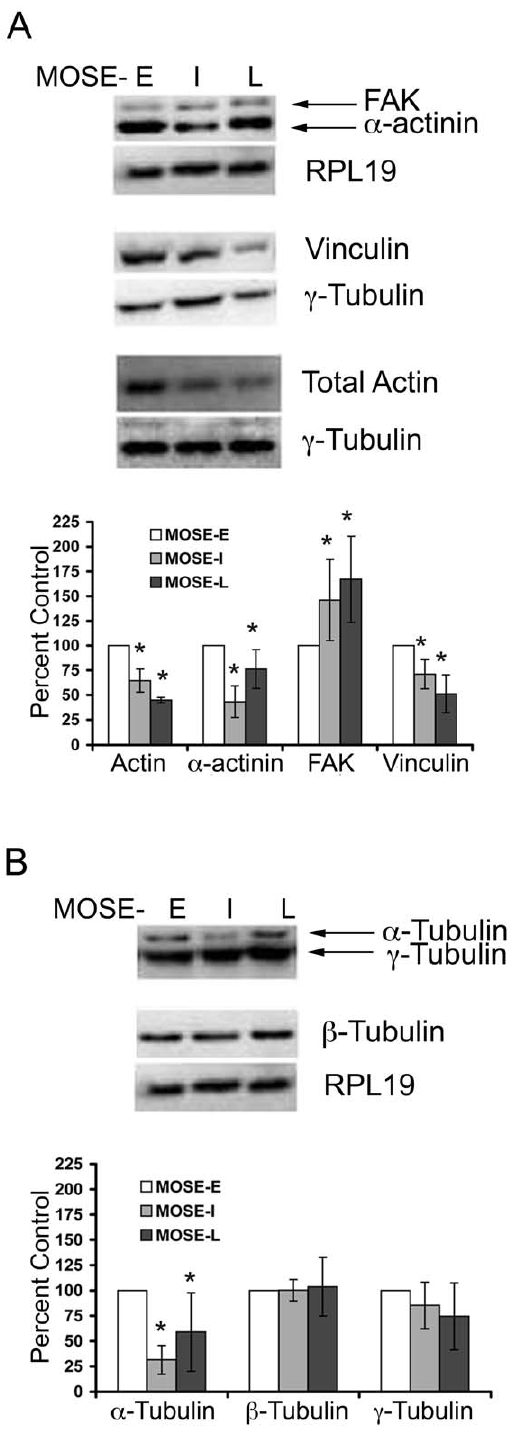
Figure 2. Levels of cytoskeleton and actin regulating proteins in neoplastic progression. Whole cell extracts from MOSE-E (E, white bars), MOSE-I (I, grey bars), and MOSE-L (L, black bars) cells were subjected to Western blot analysis with antibodies directed against ( A ) actin regulating proteins and ( B ) microtubule proteins. Expression levels are expressed as percent MOSE-E levels normalization to ribosomal protein L19 (RPL19) or c -tubulin for three biological replicates done in duplicate 6 the standard deviation. A representative blot from the three biological replicates is shown. *p # 0.01.